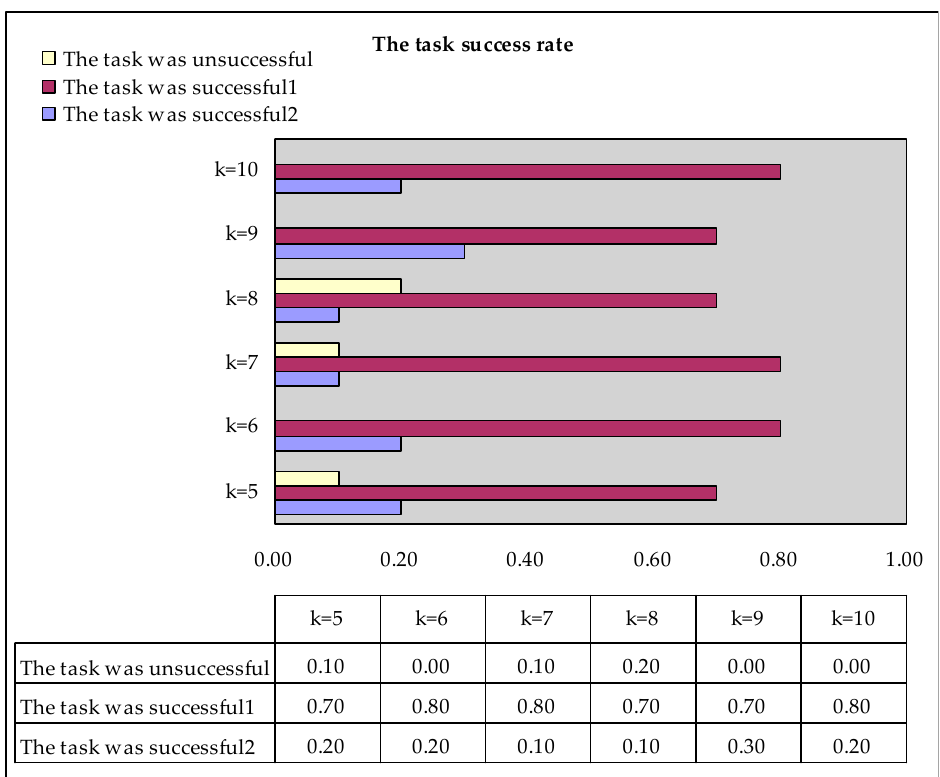
Figure 5. The task success rate.